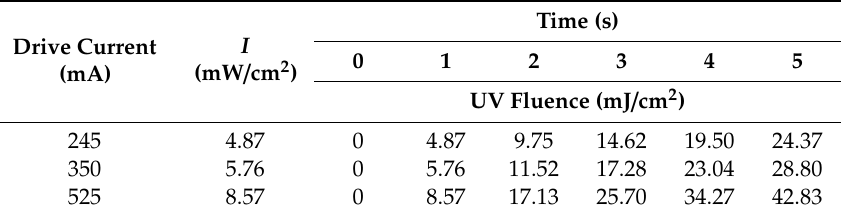
Figure 2. Linear regression for uridine UV exposures at different drive currents. The trend line was not fitted to the intercept. Table 1. UV fluence delivered by bench-scale UV-LED reactor at each drive current (derived using uridine chemical